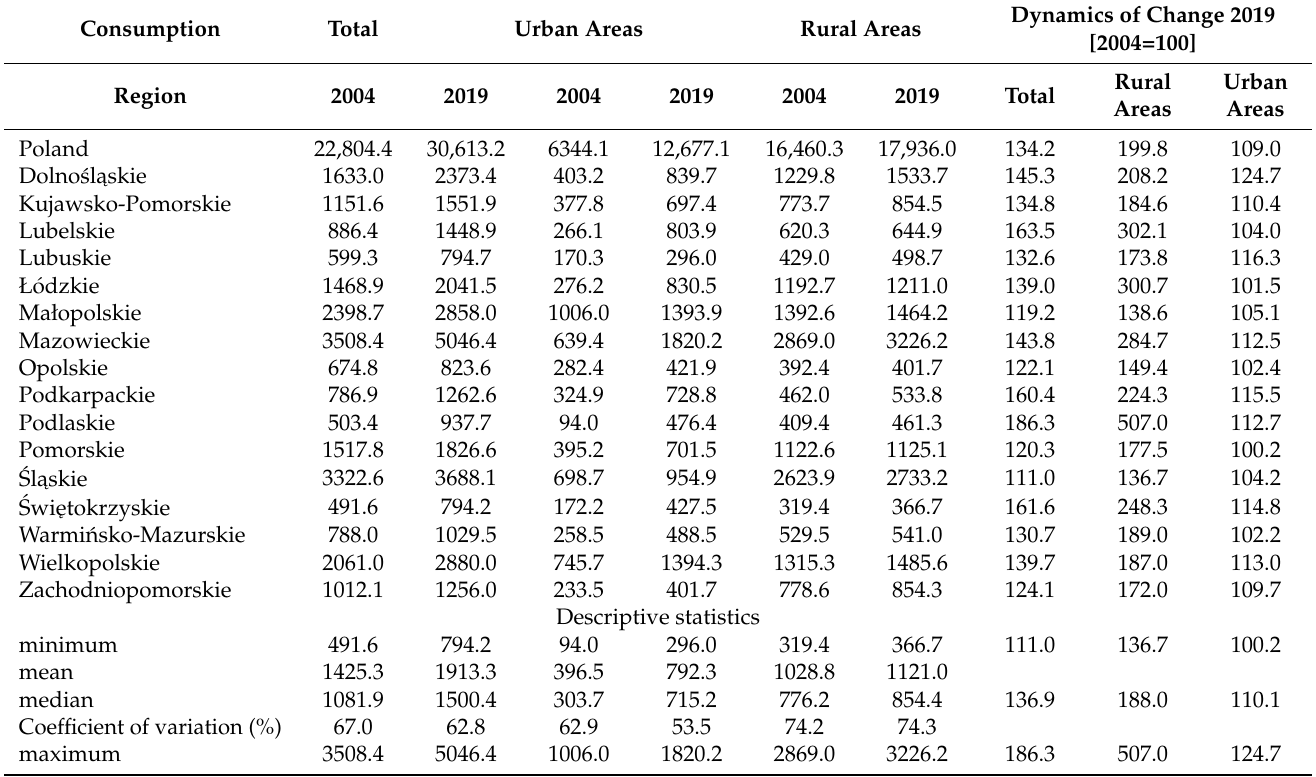
Table 3. Dynamics of change in electricity consumption in Poland (GWh).